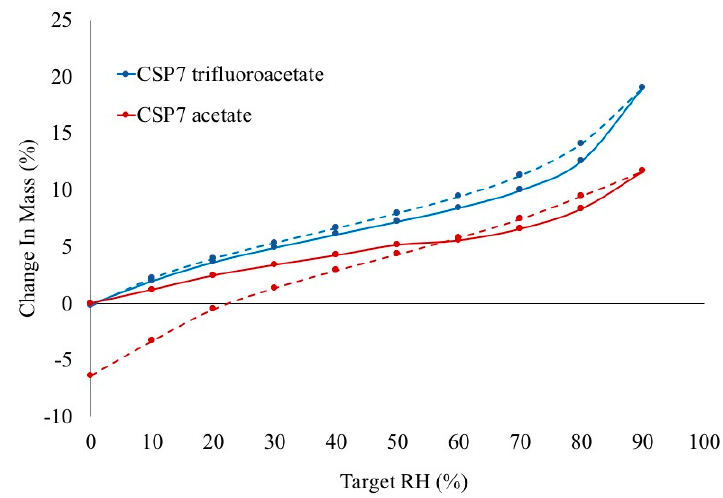
Figure 2. Moisture sorption (solid line) and desorption (dotted line) isotherms of CSP7 acetate and CSP7 TFA.